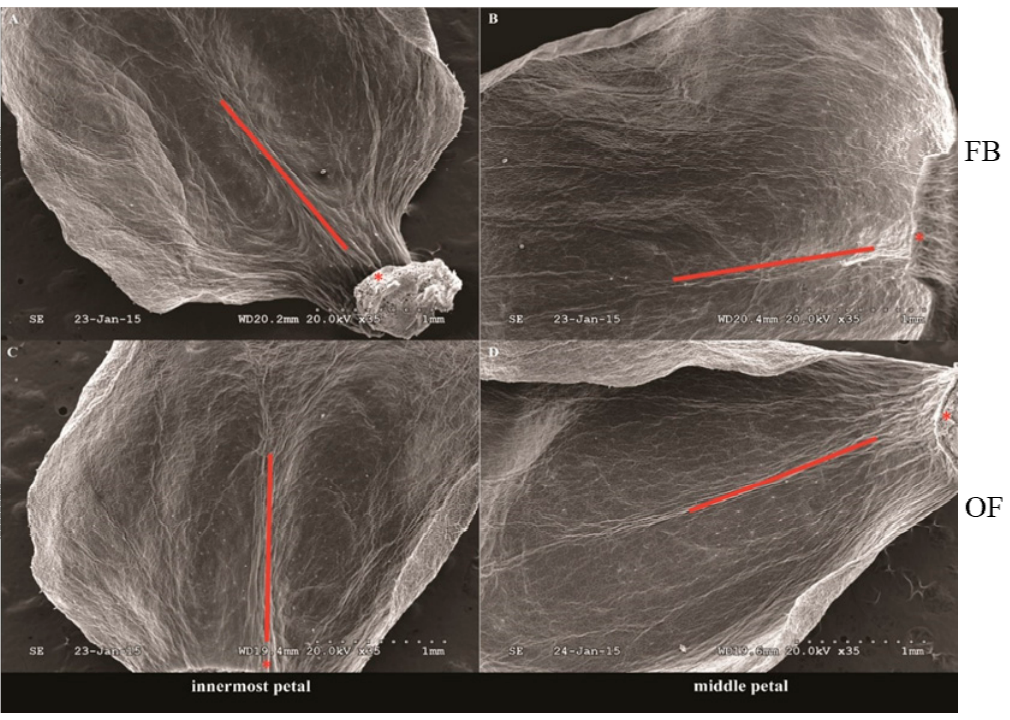
Figure 3. Distribution of the nectaries in FB and OF in the Chimonanthus praecox by SEM. Little white dot shown the nectaries concentrated near the axis of petals. Red line represented the axis of the petal. Red asterisks show the bottom of the petal.